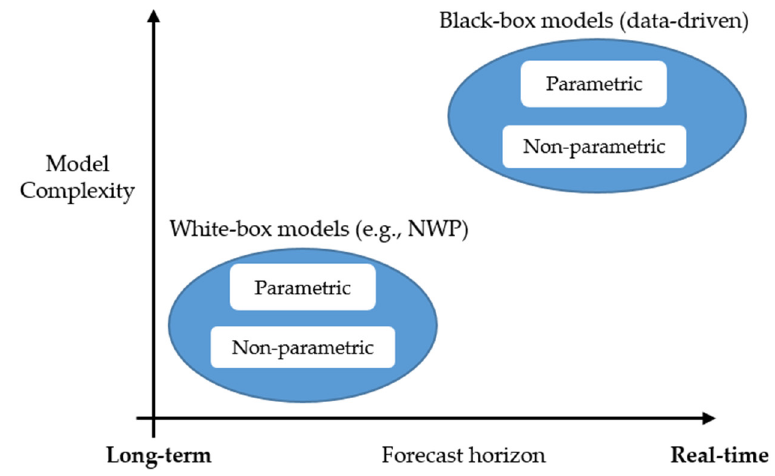
Figure 4. Probabilistic forecasting models for PV generation.